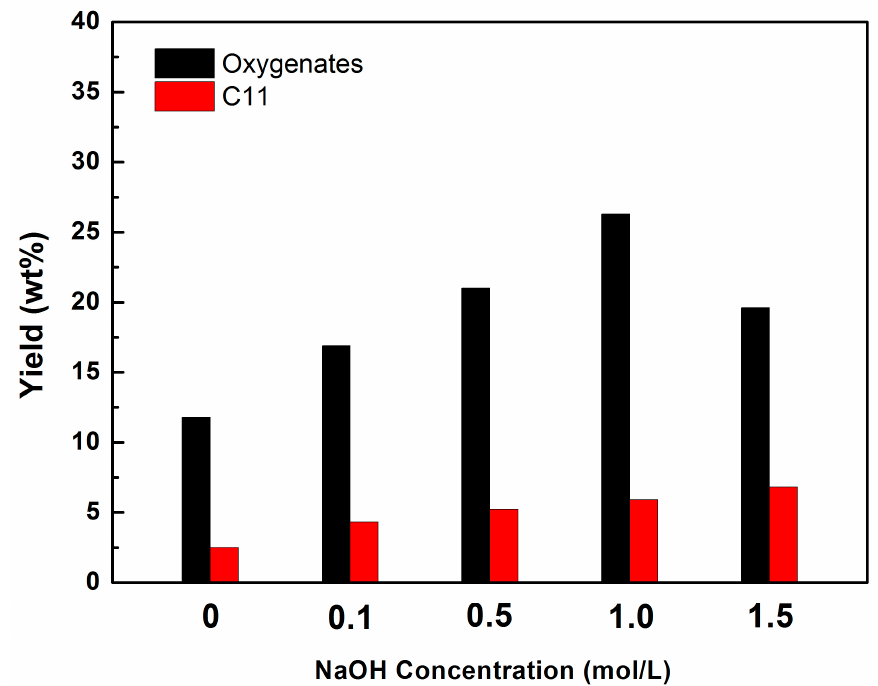
Figure 7. Yields for deoxygenation of methyl laurate in N 2 over 10 wt % Ni catalysts loaded on the hierarchical HZSM-5 treated with different concentrations of NaOH solution (0.1–1.5 M). Experimental conditions: methyl laurate (3.5 mmol), n-hexane (20 mL), catalyst (0.1 g), 280 ◦ C, 2 MPa of N 2 (Room temperature), and stirring at 600 rpm for 5 h.